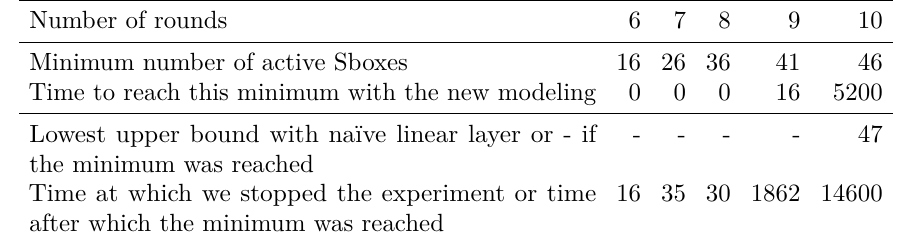
Table 6: Computation time in seconds for the Gurobi solver to find the minimum number of active Sboxes over r rounds for Skinny -128 with two different modelings for MixColumns . Number of rounds 6 7 8 9 10 Minimum number of active Sboxes 16 26 36 41 46 Time to reach this minimum with the new modeling 0 0 0 16 5200 Lowest upper bound with naïve linear layer or - if - - - - 47 the minimum was reached Time at which we stopped the experiment or time 16 35 30 1862 after which the minimum was reached